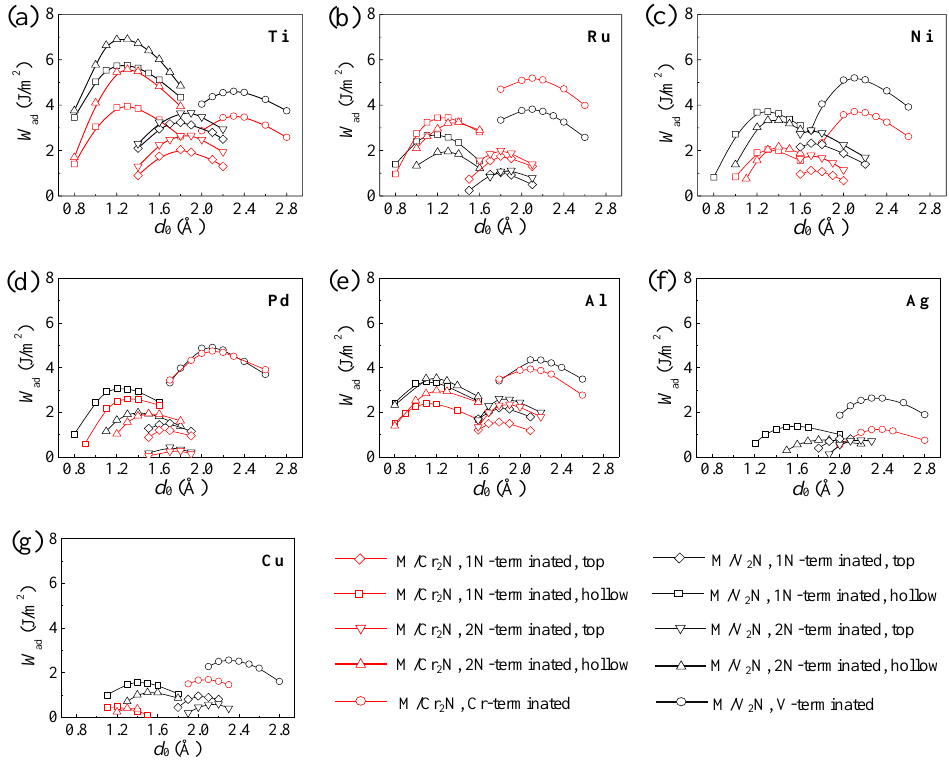
Figure 5. Relationship between the work of adhesion W ad and the interfacial distance d 0 obtained using the UBER method for every metal considered: ( a ) Ti, ( b ) Ru, ( c ) Ni, ( d ) Pd, ( e ) Al, ( f ) Ag, ( g ) Cu.